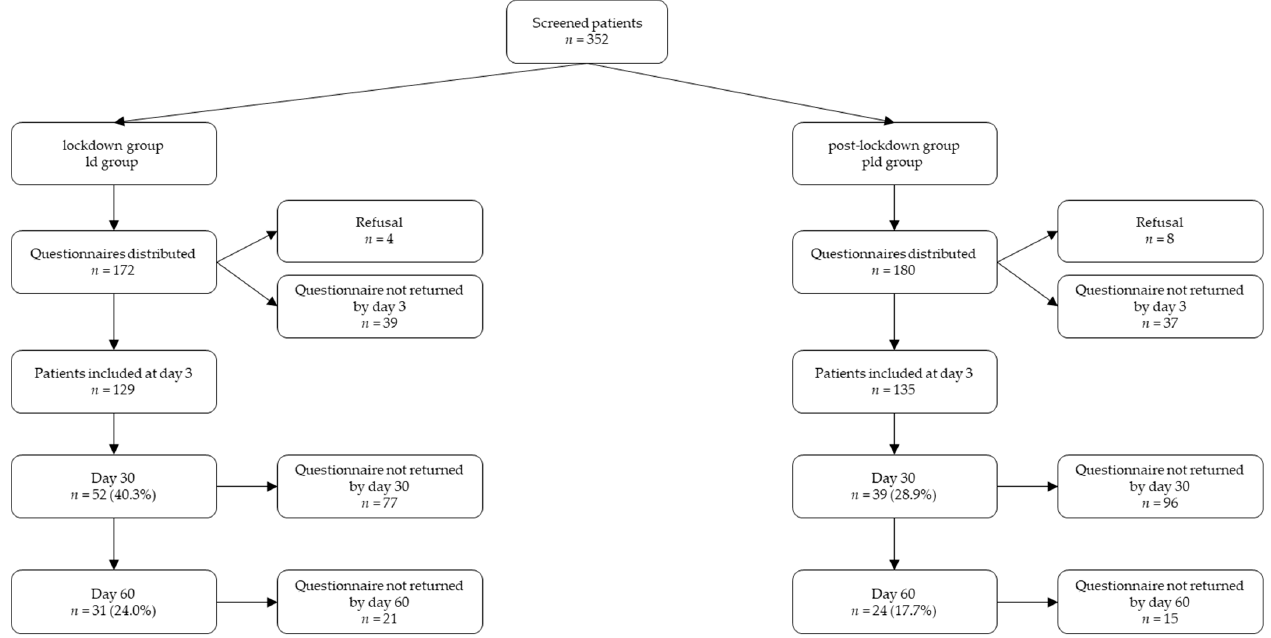
Figure 1. Flow chart.